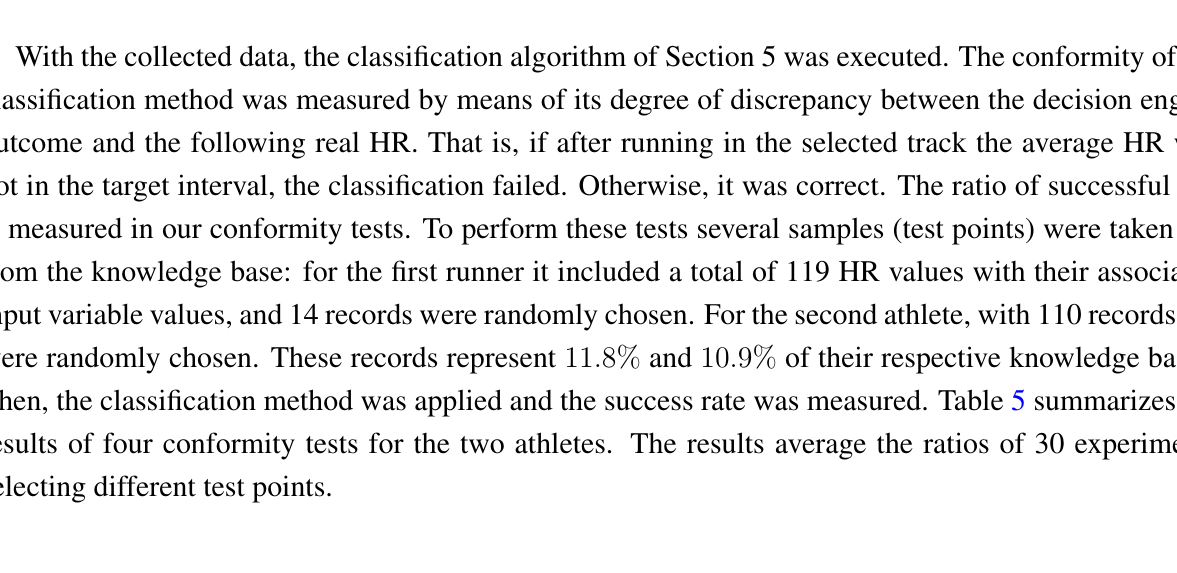
Table 5. Conformity test